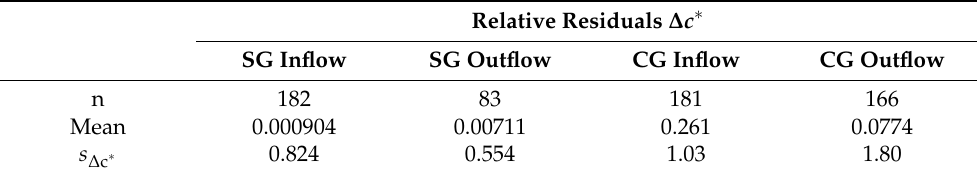
Table 7. Standard deviation and mean values for relative residuals per site and sample position.